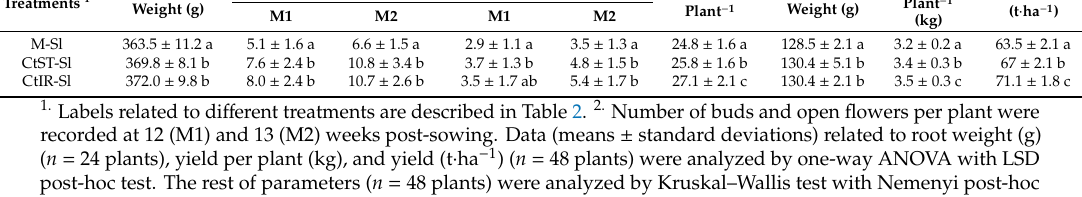
Table 5. E ff ect of Ct0861 in plant growth and yield of tomato grown in a production greenhouse. Treatments 1